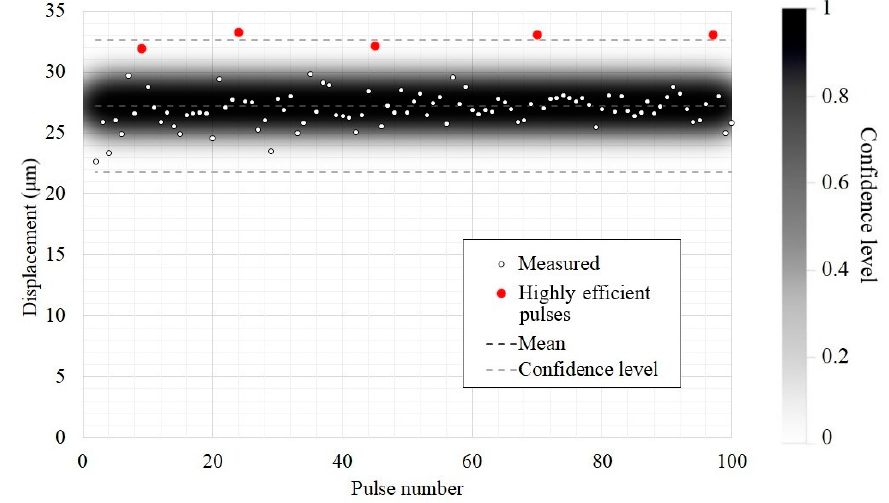
Figure 4. The displacement amplitude in the membrane center measured for 100 pulses (the scale on the right level of confidence).